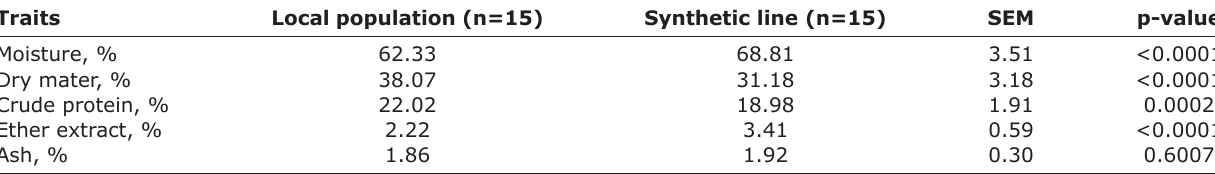
Table-4: Chemical meat composition in the local population and the synthetic line. Traits